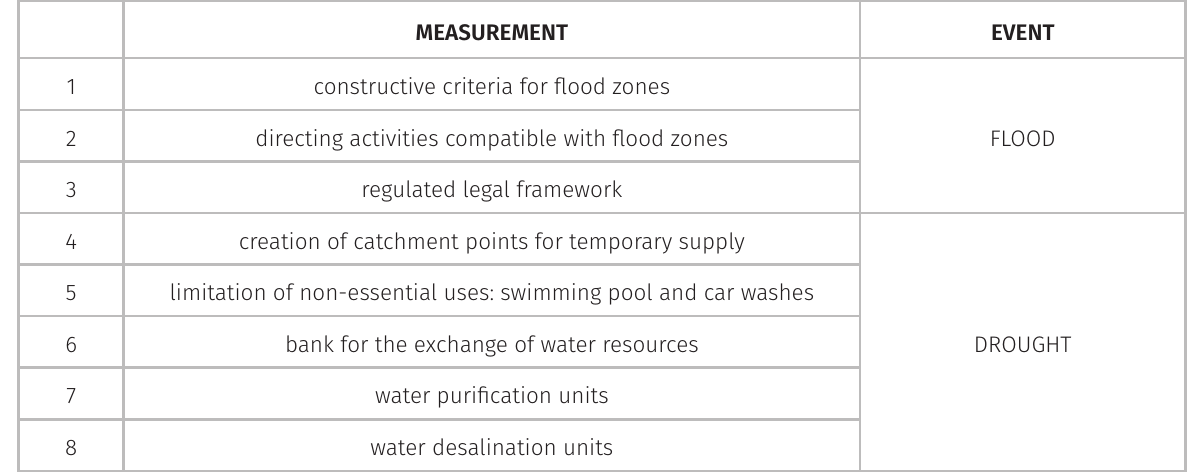
Table VI. Contributions of the water conflicts management system with the use and occupation of the